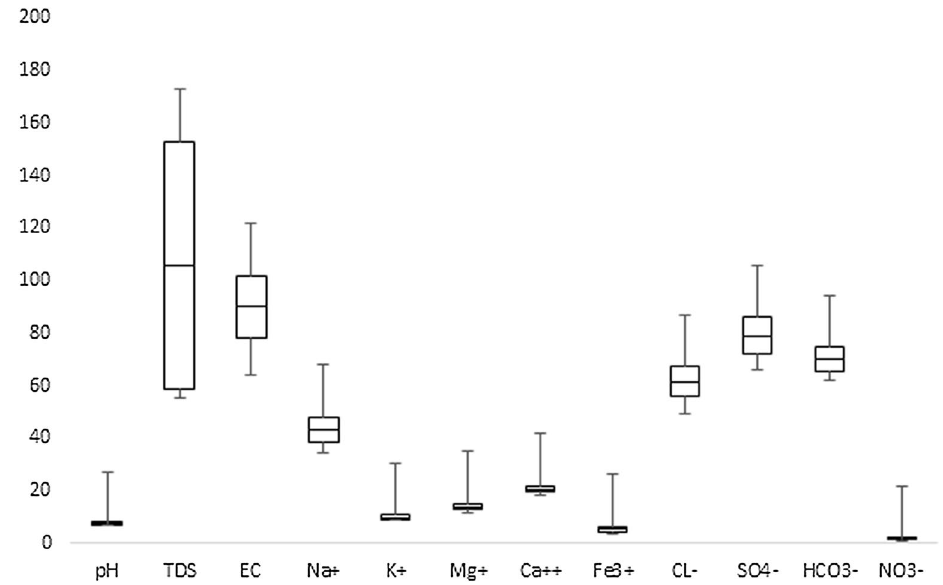
Fig. 9 Boxplot of groundwater samples collected from